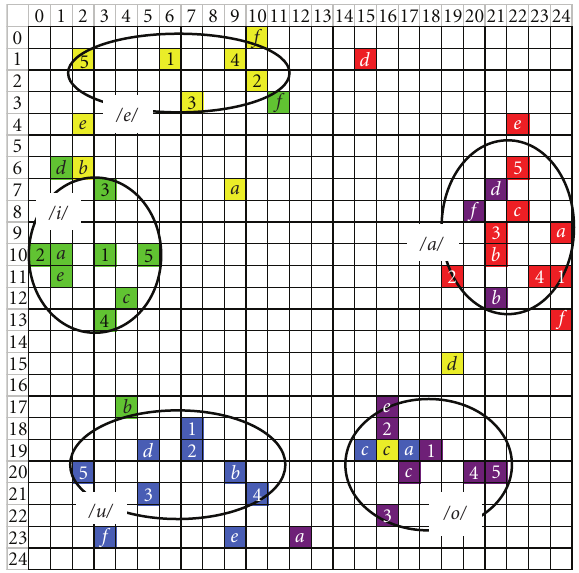
Figure 3: Result of reinforcement learning with five Japanese vowels from 5 subjects no. 1–5.